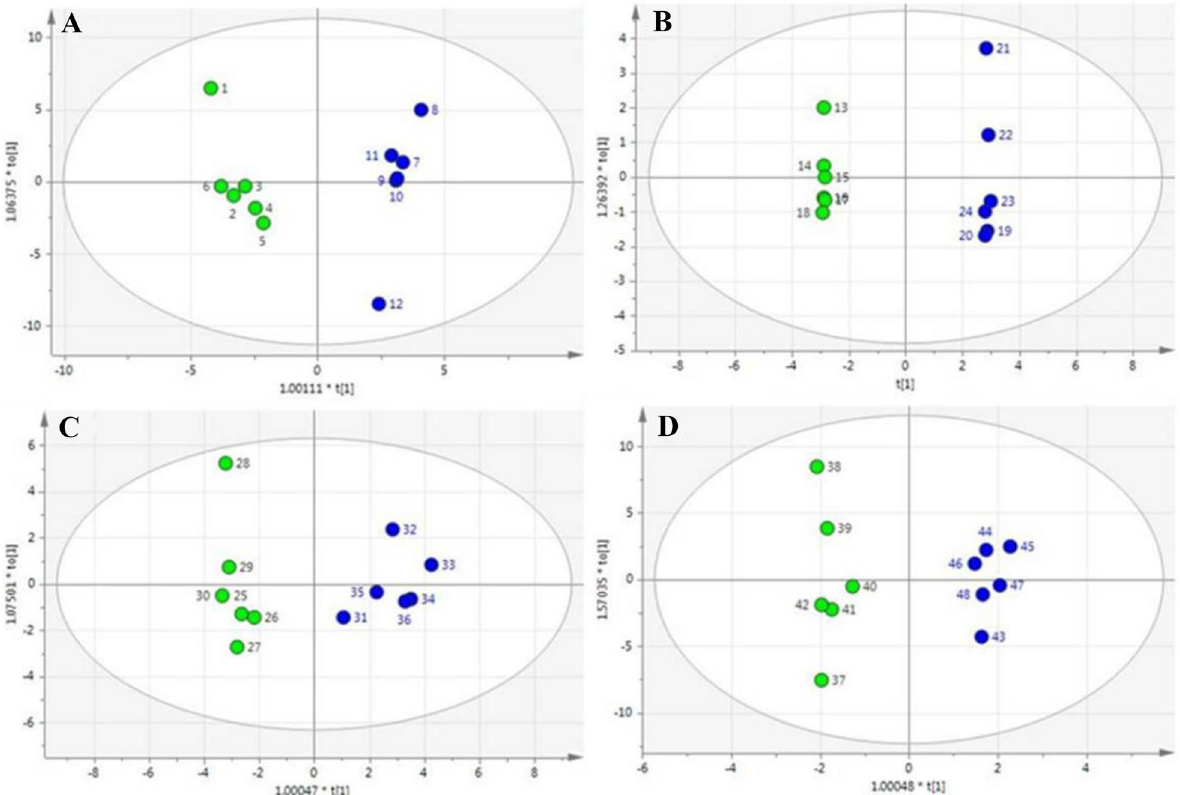
Fig. 3 PLS-DA derived plots for pairwise comparisons between the Na-citrate and control groups at various time points: A 48 h, B 72 h, C 96 h, and D 120 h. Green circle: control groups. Blue circle: Na-citrate-treatment